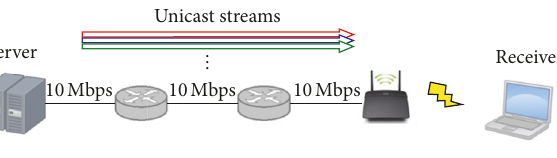
Figure 14: Experimental network scenario 3.